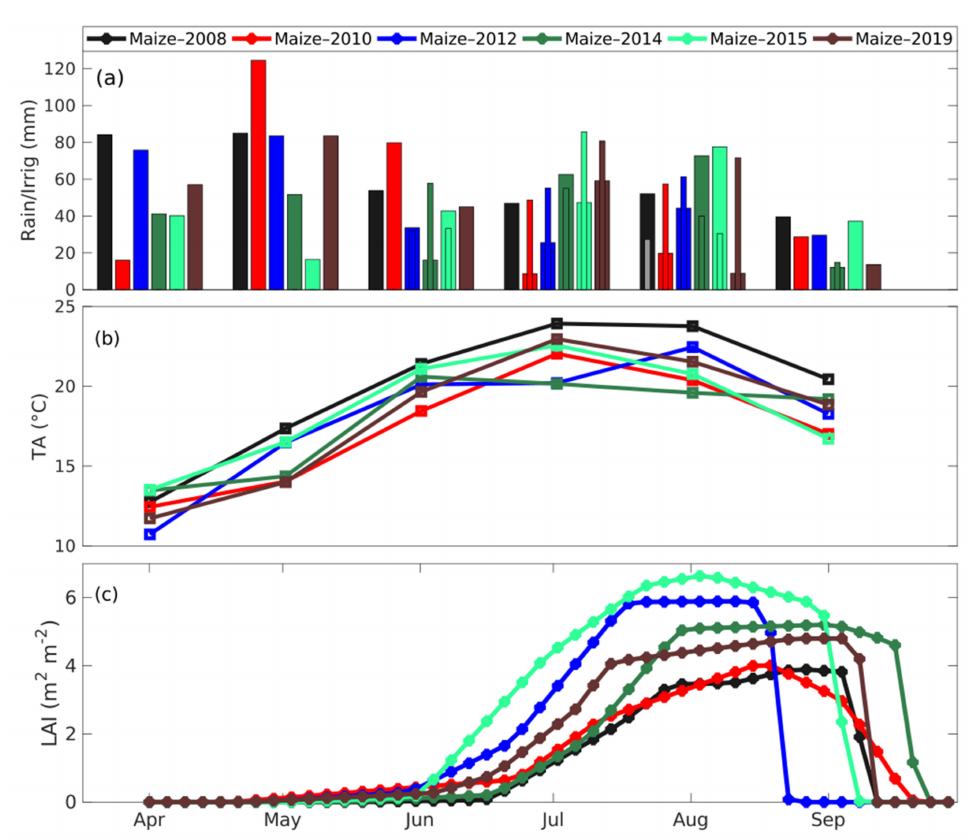
Figure 2. ( a ) Monthly observation of total rainfall (in large bars) and irrigation amount (in thin bars), ( b ) monthly averaged air temperature, and ( c ) 4-days mean of the leaf area index for the six maize seasons in FR-Lam